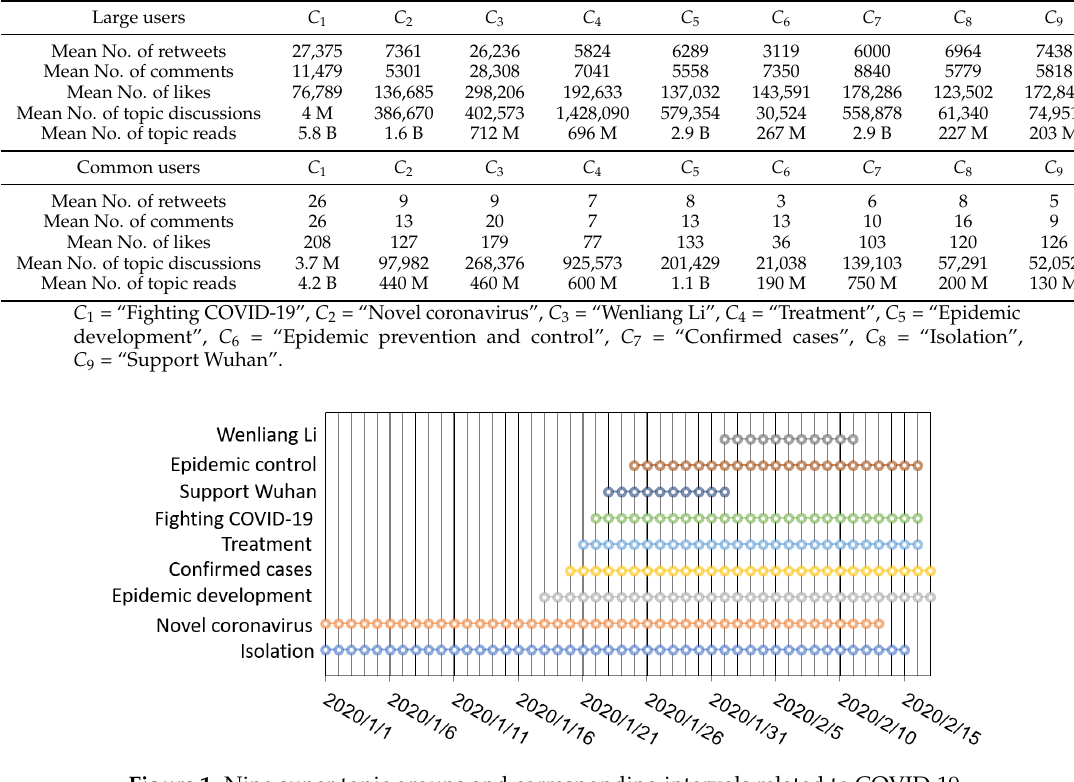
Figure 2. The extraction results before 21 January 2020 are not shown owing to the low posting